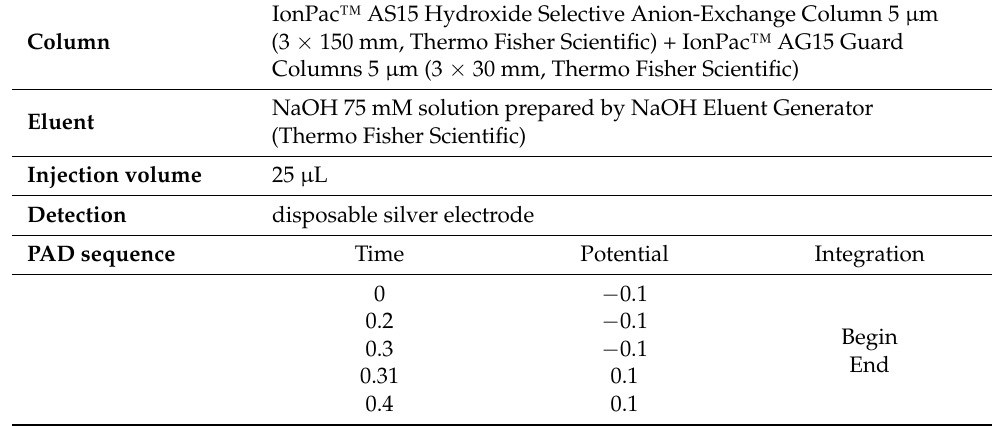
Table 5. Chromatographic and detection